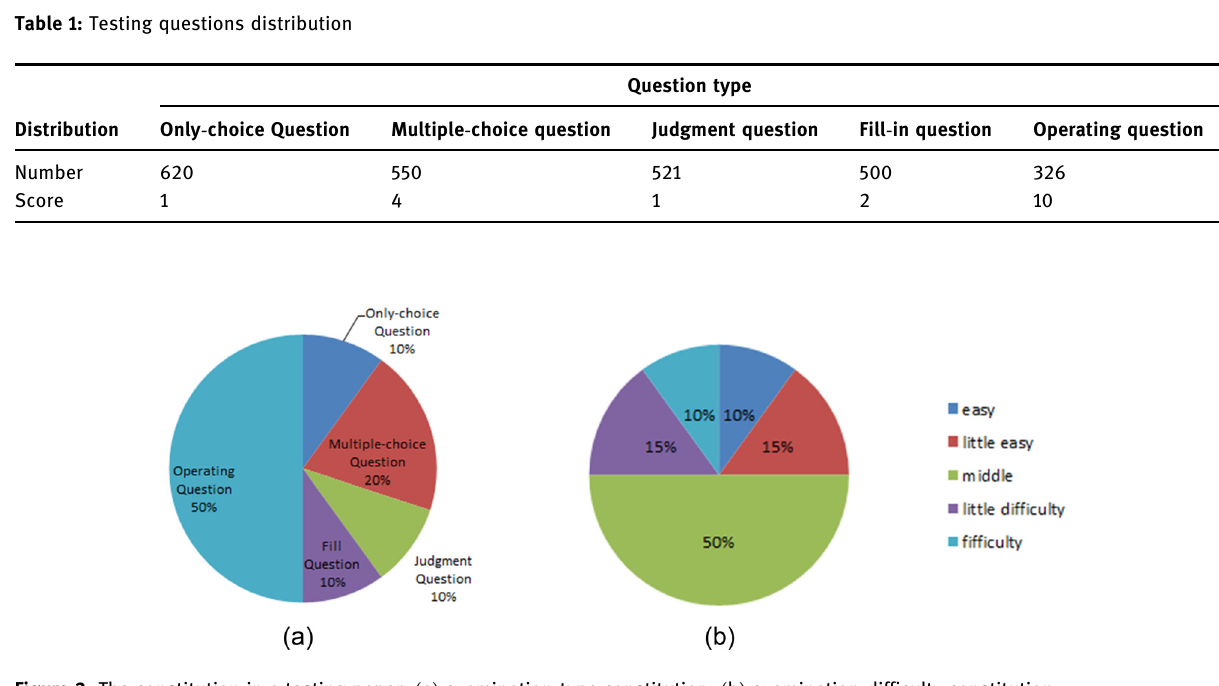
Figure 2: The constitution in a testing paper: ( a ) examination - type constitution; ( b ) examination - di ffi culty